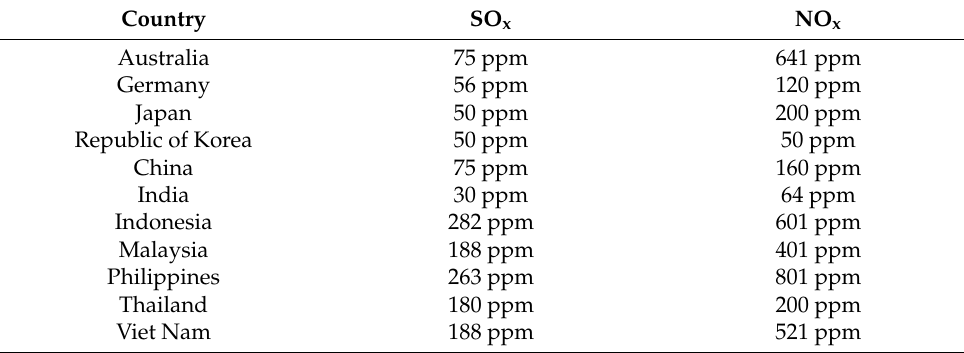
Figure 7. Relative performance values for three fuels ( R d = 2 mm, T g = 900 °C). Table 8. Emission standards for new CPPs in selected countries [88].